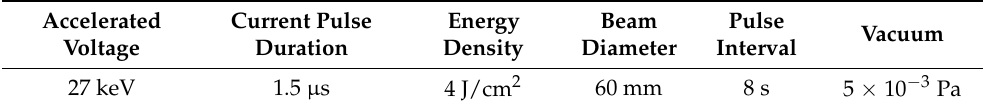
Table 1. Parameters of HCPEB